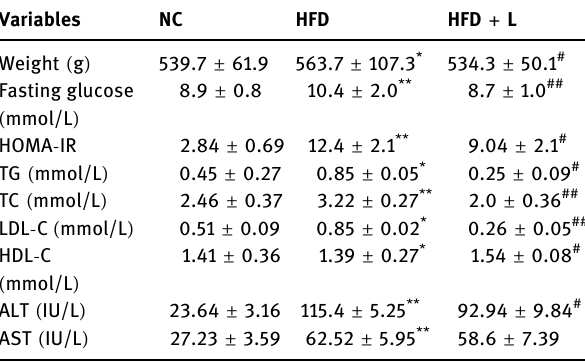
Table 1: E ff ect of liraglutide on weight, serum fasting glucose levels, insulin resistance, lipid pro fi les, and liver enzymes in rats Variables